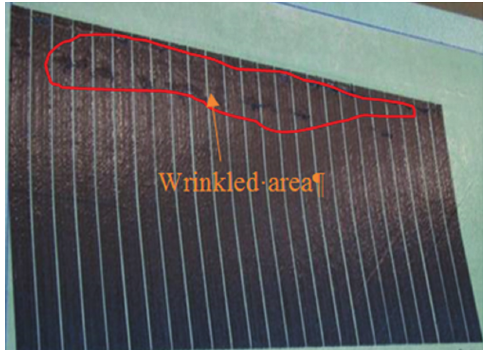
Figure 8 Fiber steering trial case 1: θ = 5 ° , ply 2, laid down at 2 m/min.